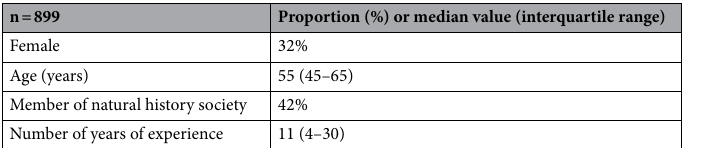
Table 1. Profile of the